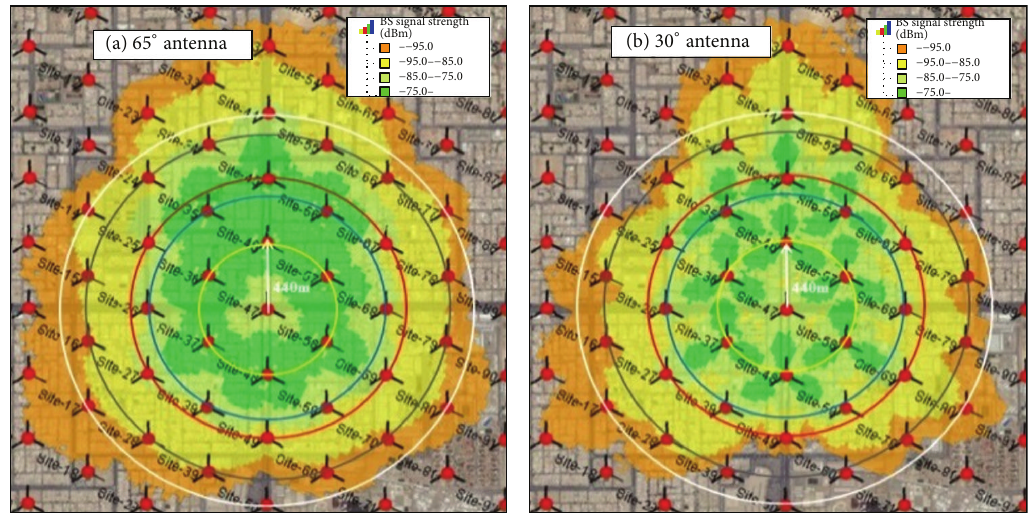
Figure 2: RF coverage of interfering trisector BS’s with significant received signal strength on the sector of site-58 in the direction of the arrow for 𝑓 𝑐 = 28 GHz and various TX antenna beamwidths: (a) 65 ∘ , (b) 30 ∘